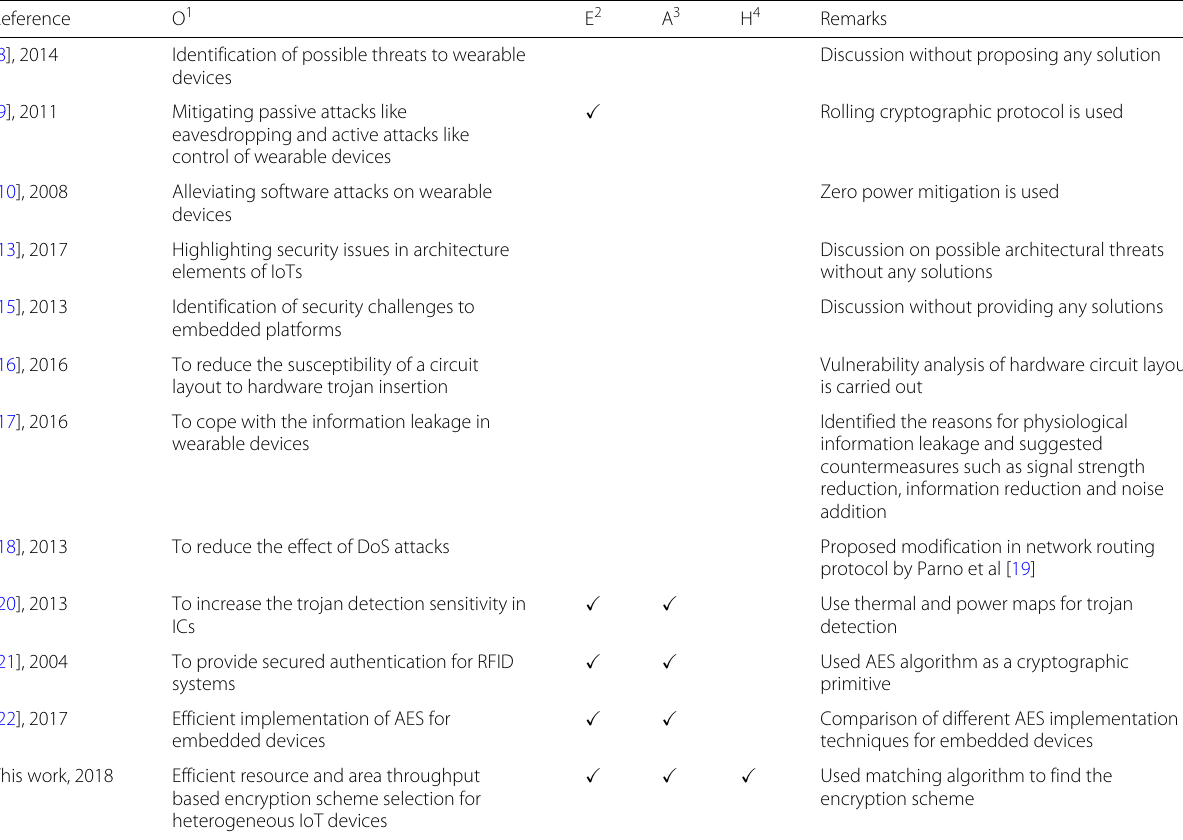
Table 1 Summary of related work Reference